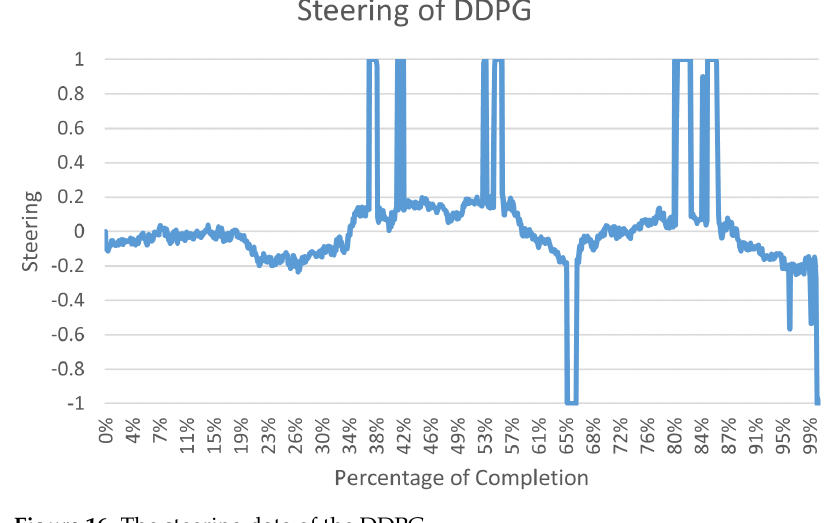
Figure 16. The steering data of the DDPG.